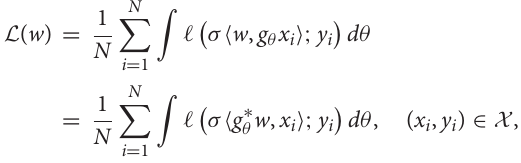
TABLE 3 | Training a linear classifier to separate single-image masks trained on the test images of X . M N , X M N , X True labels Shuffled